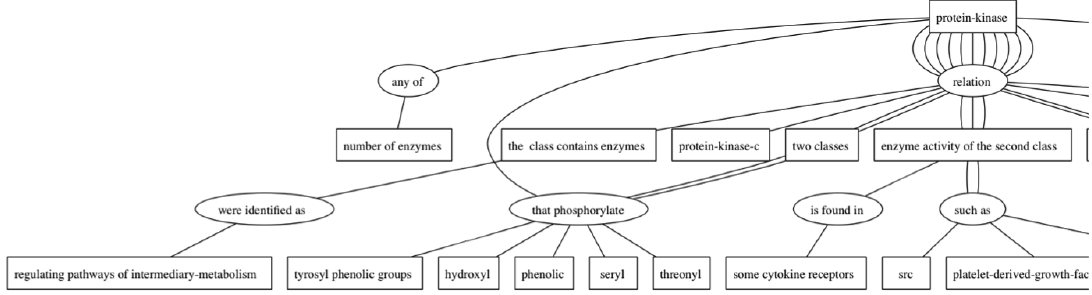
Figure 9: Partial High Level Ontology from Coffee